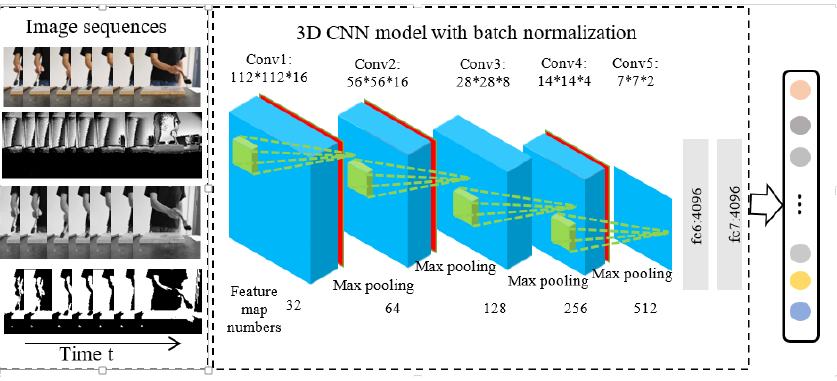
Figure 3. 3D CNN model with batch normalization.